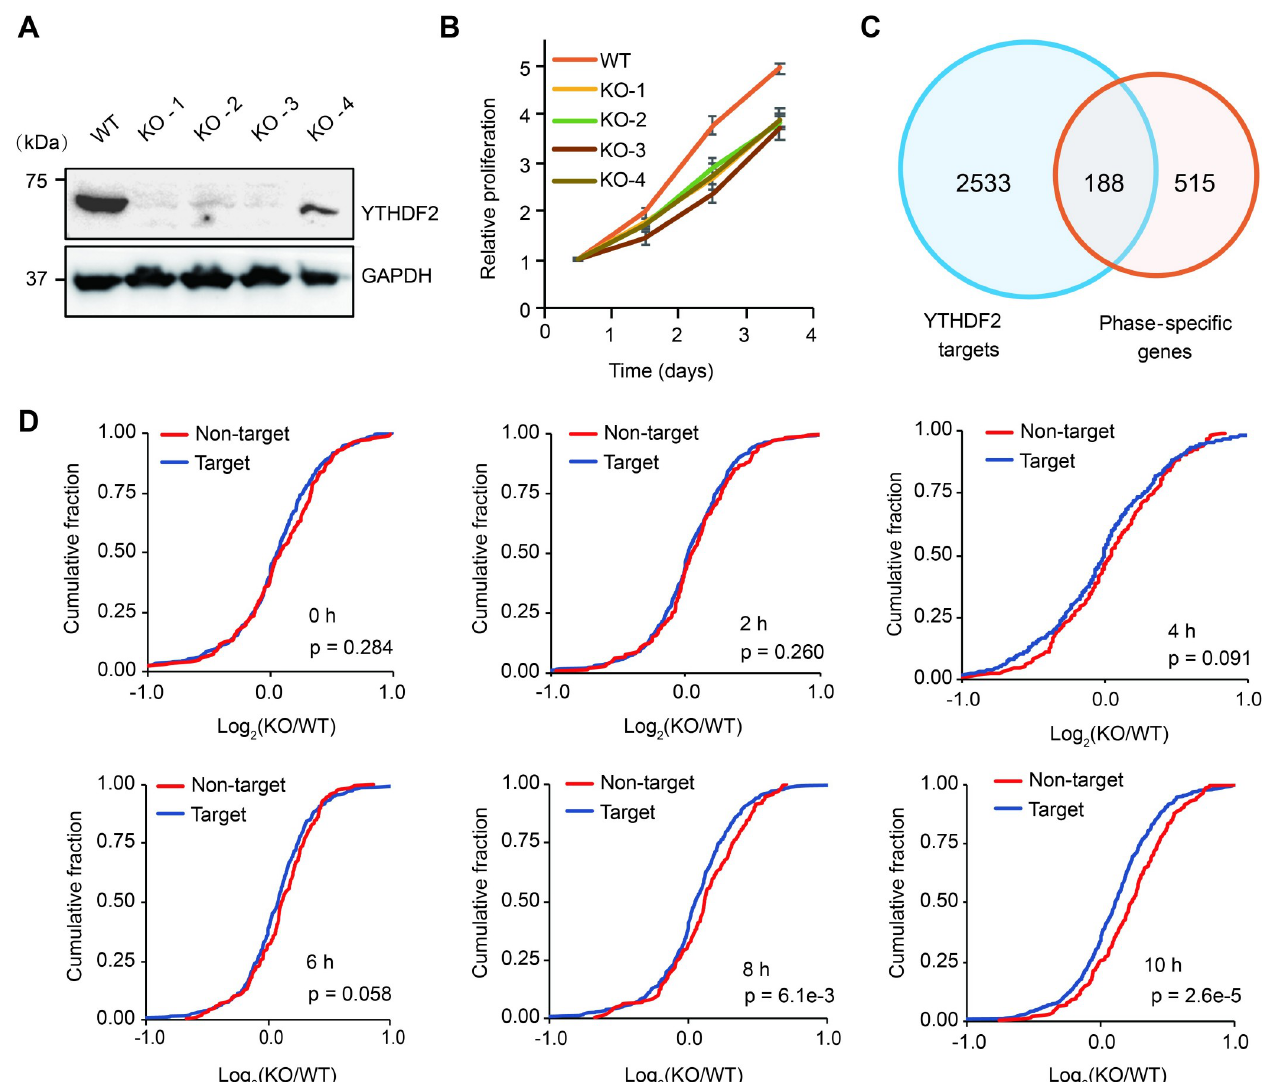
Fig 2. YTHDF2 depletion delays cell proliferation and elevates target transcripts. (A) Western blot of YTHDF2 in CRISPR-Cas9 KO cell lines. (B) Cell proliferation assays of WT and YTHDF2 KO cell lines. (C) Intersection of genes that are confident YTHDF2 targets and the ones that are phase specific. (D) Cumulative distribution of phase-specific transcripts that are YTHDF2 bound (188 genes, in red) and unbound (515 genes, in blue) by comparing WT and KO cell lines. The x-axes indicate the log2 fold change of gene expression in KO versus WT. P values were calculated using the Mann-Whitney test. Underlying data for this figure can be found in S1 Raw Images and S1 Data. GAPDH, glyceraldehyde 3-phosphate dehydrogenase; KO, knockout; WT, wild type; YTHDF2, YTH N 6 -methyladenosine RNA binding protein 2.